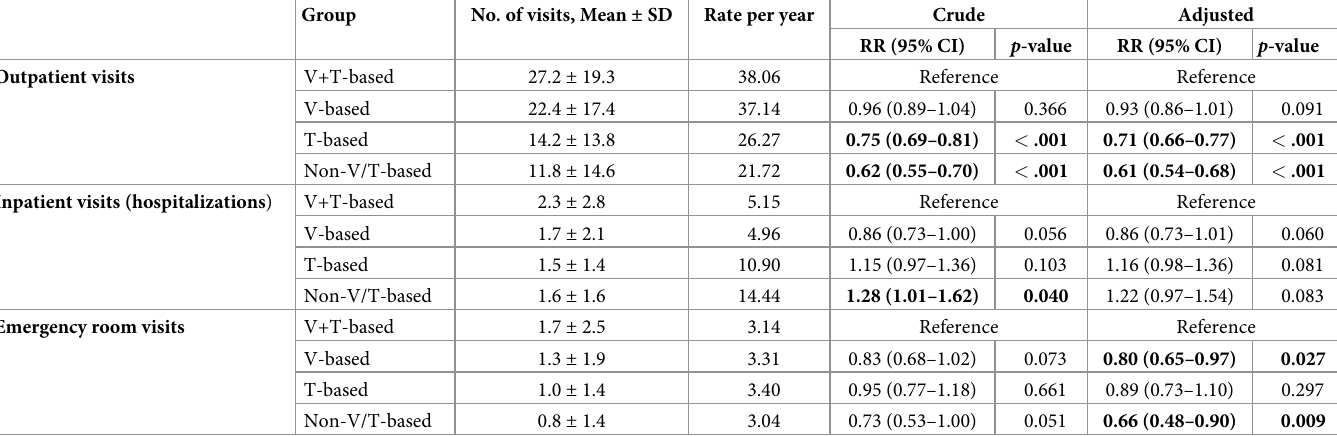
Table 3. Crude and adjusted rate ratios of health care resource utilization among different 1LOT